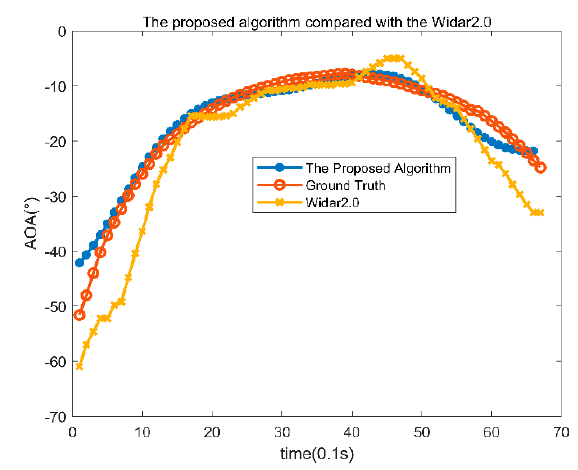
Figure 10. AOA results of corridor T01 data.